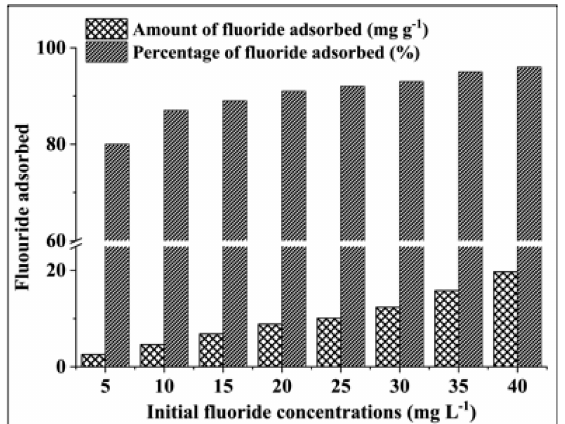
Figure 5. Amount and percentage of fluoride adsorbed for different initial fluoride concentrations in the absence of calcium.